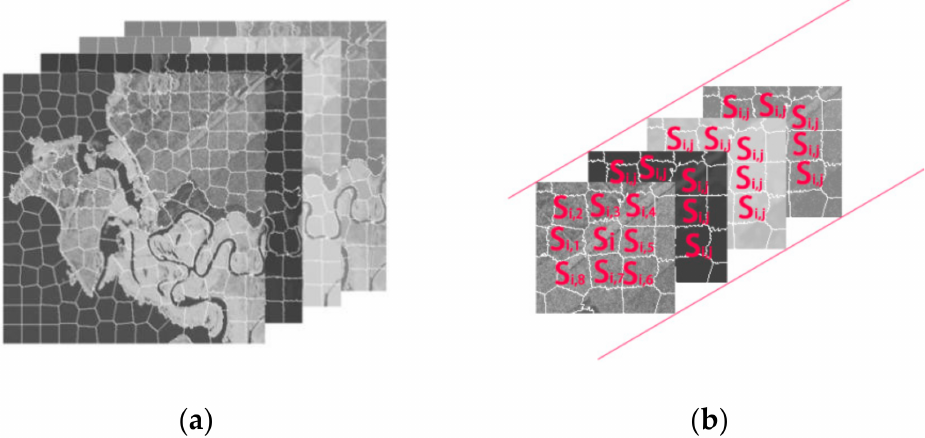
Figure 3. ( a ) Adaptive feature blocks and ( b ) generalized neighborhood of an adaptive block S i